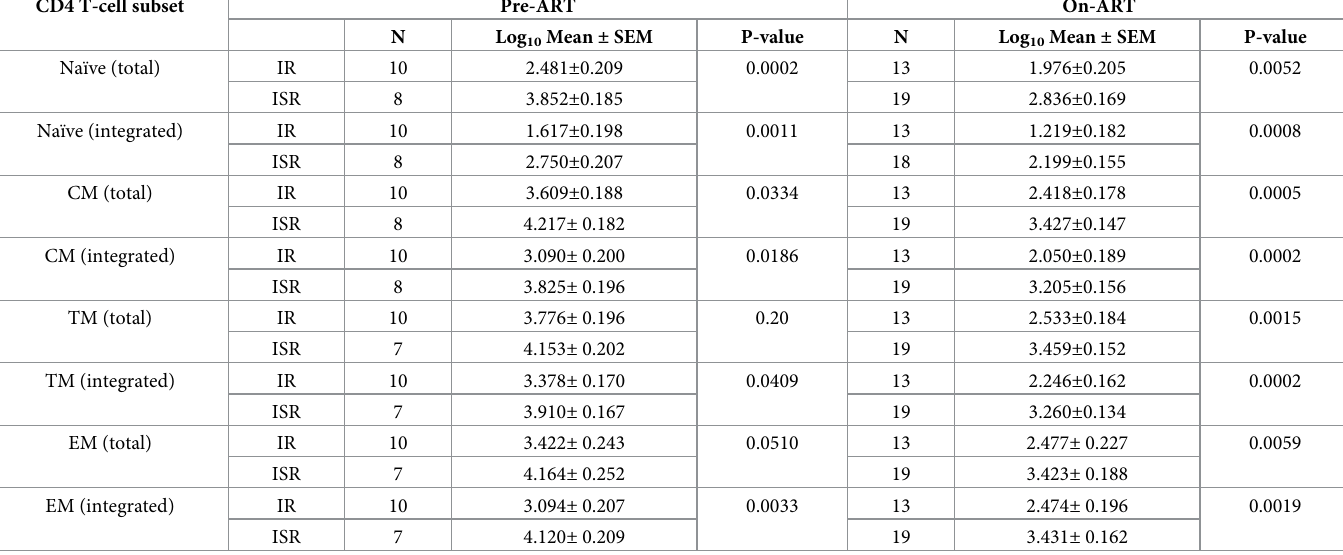
Table 1. Estimated means and 95% confidence intervals for HIV-DNA levels in blood (PBMC) CD4 T-cell subsets (Na ï ve, CM, TM and EM cells) in univariate repeated-measures